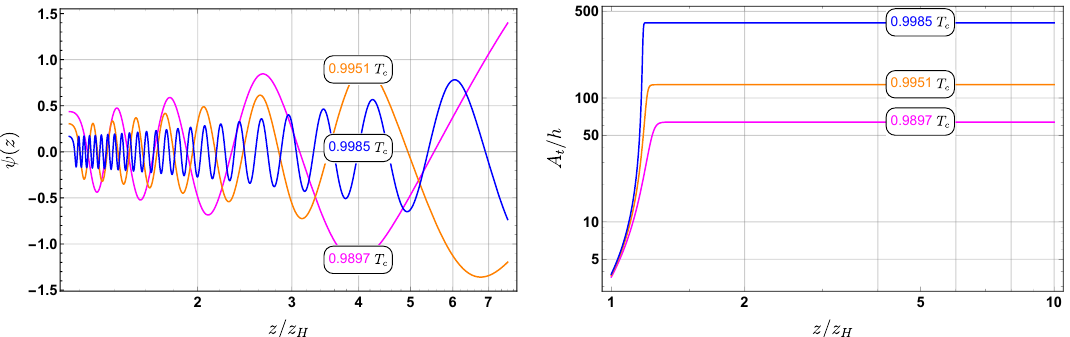
Figure 6 . Interior dynamics in the Josephson oscillation epoch at different temperatures. Left: The scalar oscillation as a function of z/z After a short period of growth, A